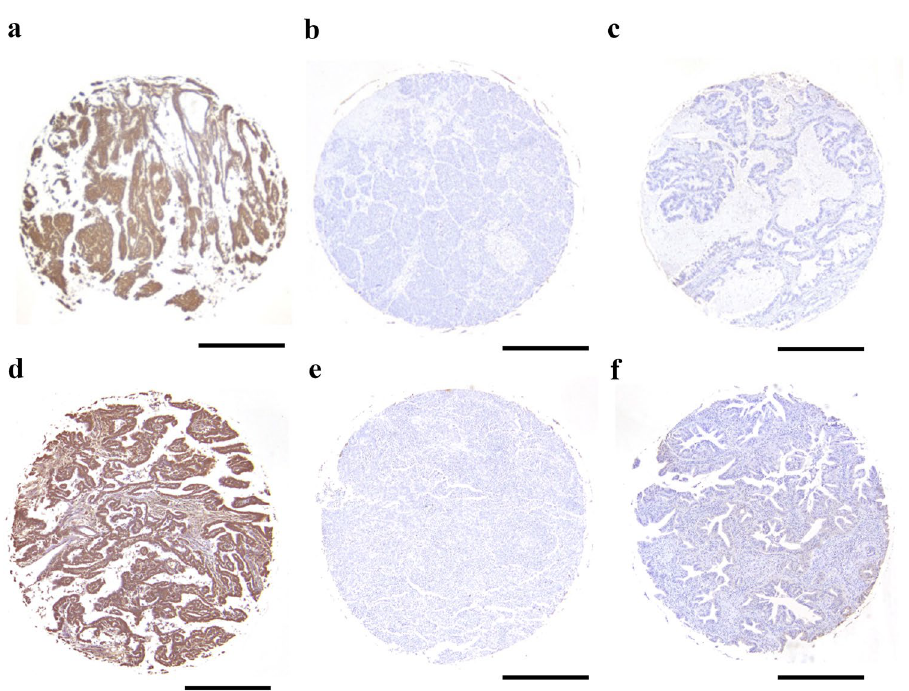
Figure 2. Immunohistochemical image of tissue microarray cores. Diameter, 1.5 mm. ( a ) Epithelioid malignant pleural mesothelioma positive for RhoA; ( b ) Lung squamous cell carcinoma negative for RhoA; ( c ) Lung adenocarcinoma negative for RhoA; ( d ) Epithelioid malignant pleural mesothelioma positive for vigilin; ( e ) Lung squamous cell carcinoma negative for vigilin; and ( f ) Lung adenocarcinoma negative for vigilin. Original magnification is × 100 for all. A scale bar shows 0.5